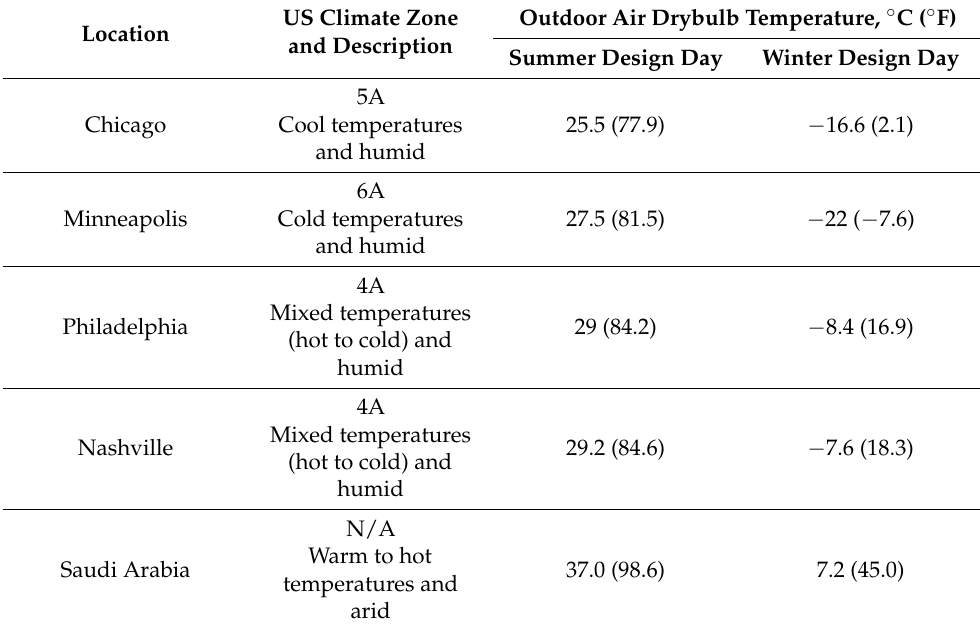
Table 5. Locations utilized for building energy simulations with EnergyPlus reference buildings.